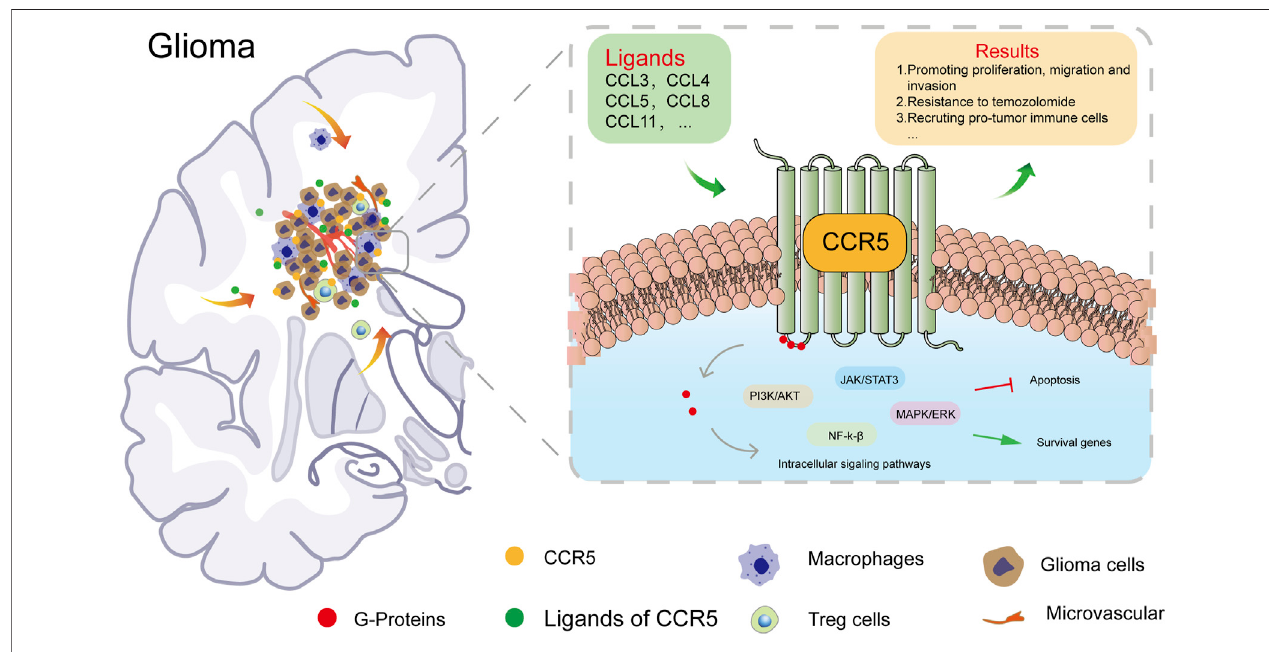
FIGURE 9 | Expression and role of CCR5 in